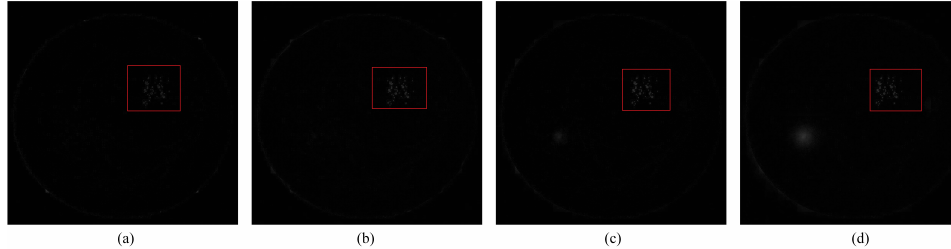
Figure 14. Influence of patch size on detection results in the P-RPCA method for the image pair with small lesions. ( a ) Patch size = 50; ( b ) patch size = 100; ( c ) patch size = 200; and ( d ) patch size =